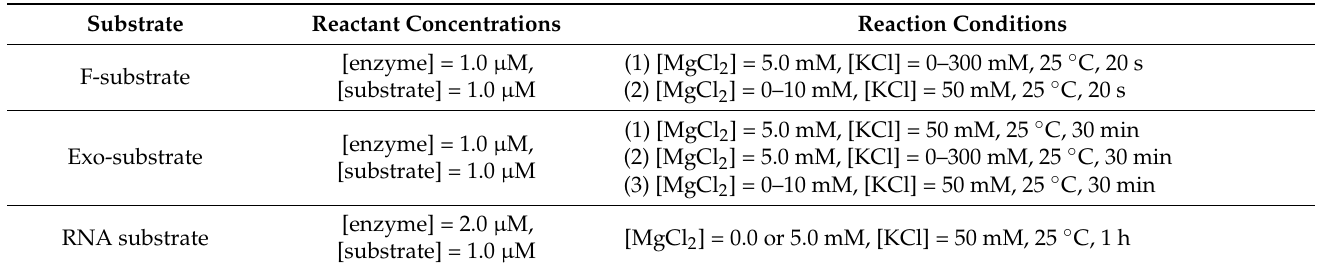
Table 2. Reaction conditions for the comparison of cleavage activity among APE1-like